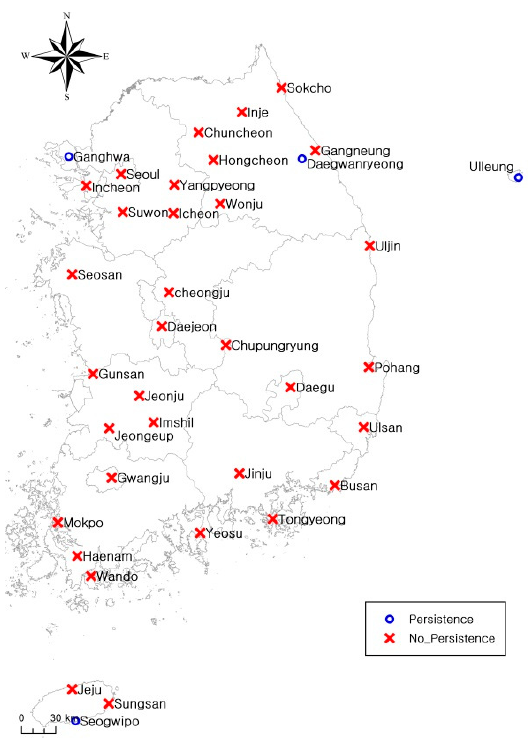
Figure 10. Persistence analysis result for each station.